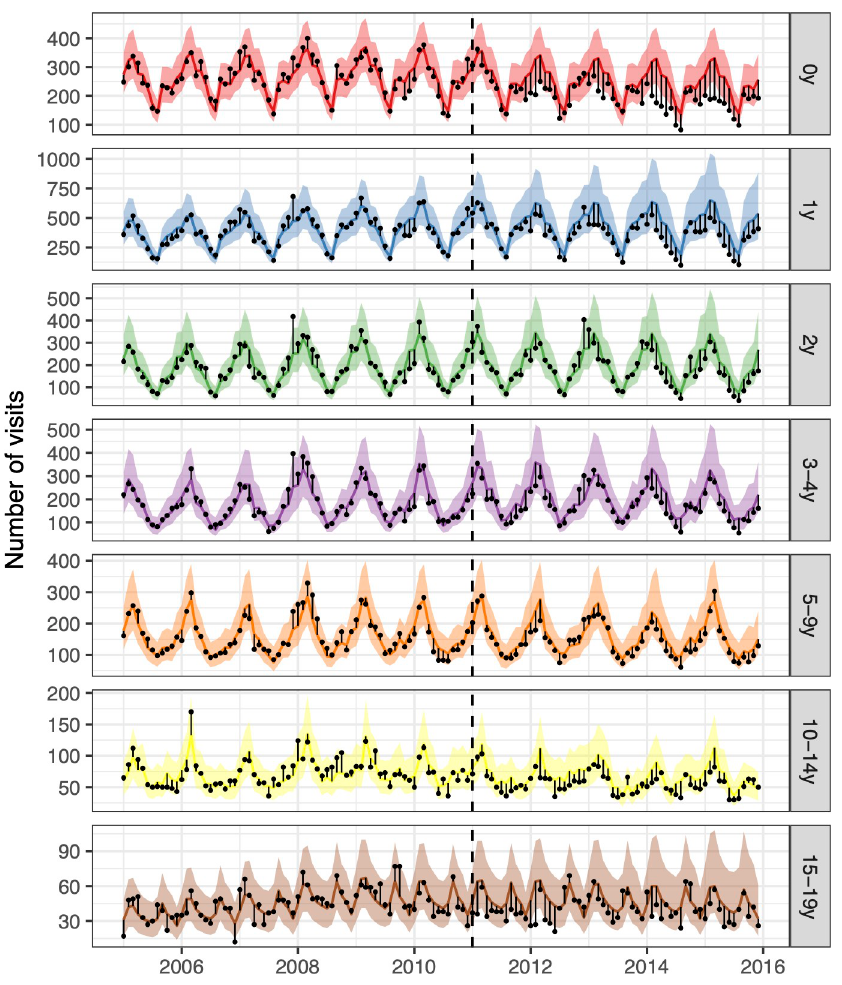
Fig 1. The observed and predicted number of AOM visits from 1 January 2005 to 31 December 2015 for each age- group. Observed visits are illustrated as black points, the posterior predicted visits are presented as lines and 95% credible intervals as a shaded area. The start of the vaccine period is delineated with a vertical black dashed line. The distance between the observed and predicted visits for each calendar-month is depicted by a thin black line. Assuming that the model was correct, and that no intervention took place, the black points would have an equal probability of occurring above or below the prediction line. Points below the lower bound of the shaded area would then represent observations with less than a 2.5% probability of occurring. The scale of the Y-axes differs between